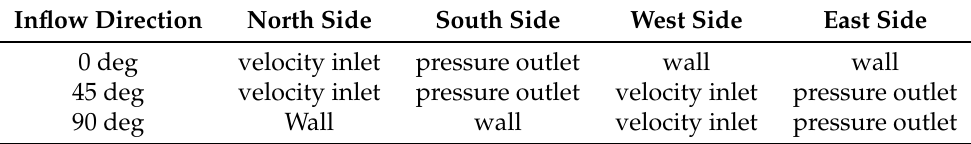
Table 3. Boundary conditions corresponding to the flow